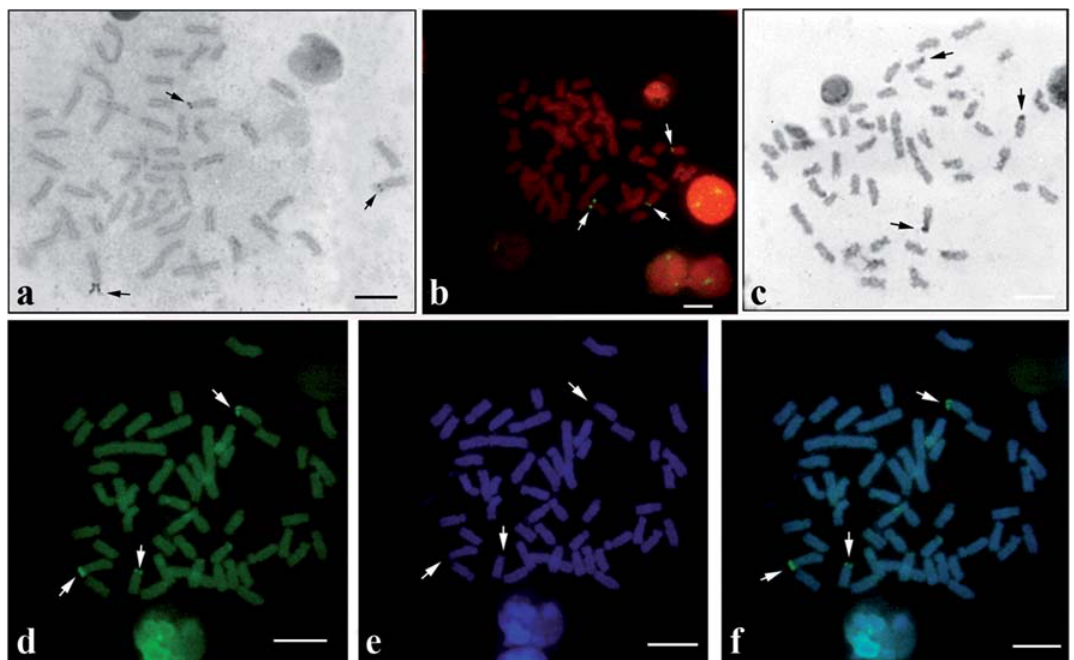
Fig. 2. Metaphases of Astyanax laticeps : (a) Ag-NORs stained; (b) Fluorescent in situ hybridization with 45S rDNA probe; (c) C-banding; (d) CMA staining; (e) DAPI staining; (f) Overlapping of CMA 3 the NORs. Bars = 5 µ m.